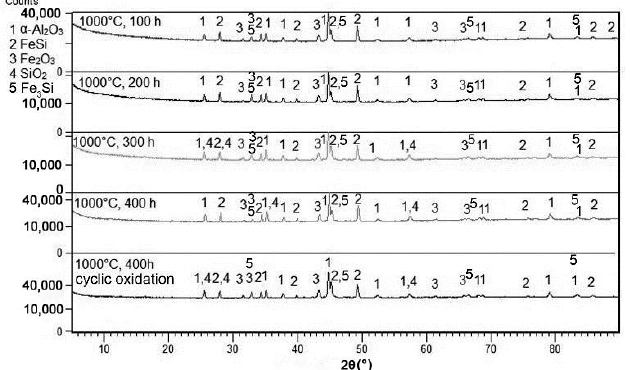
Figure 3. XRD patterns of FeAl20Si20 alloy after various durations of oxidation at 800 °C in air.